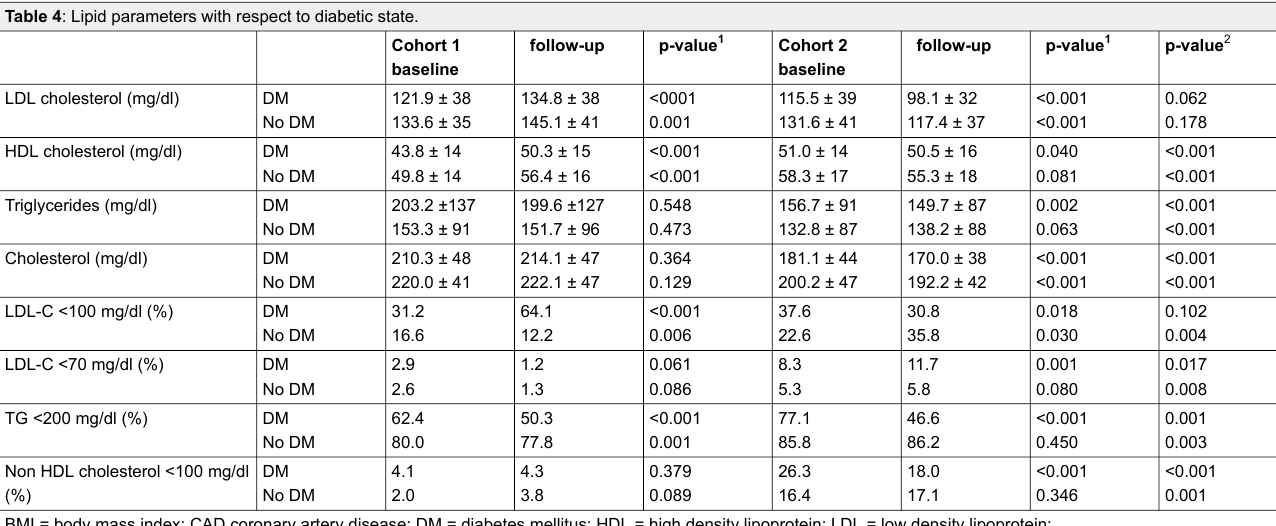
Table 4 : Lipid parameters with respect to diabetic state.